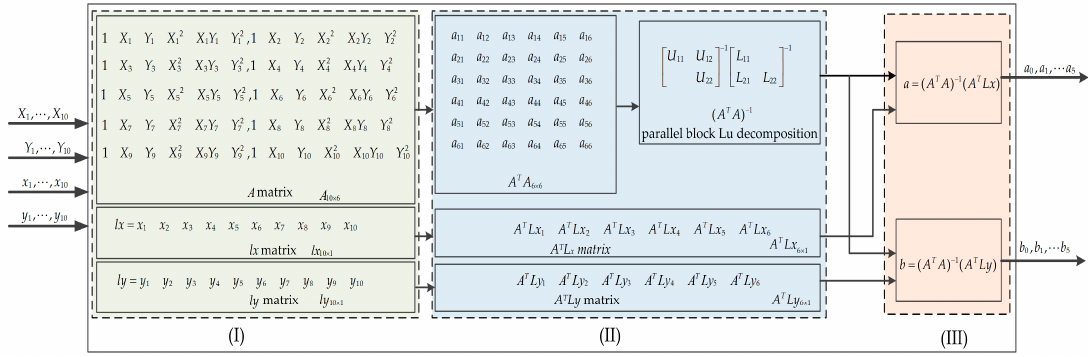
Figure 5. The proposed parallel implementation of the solving coefficient.